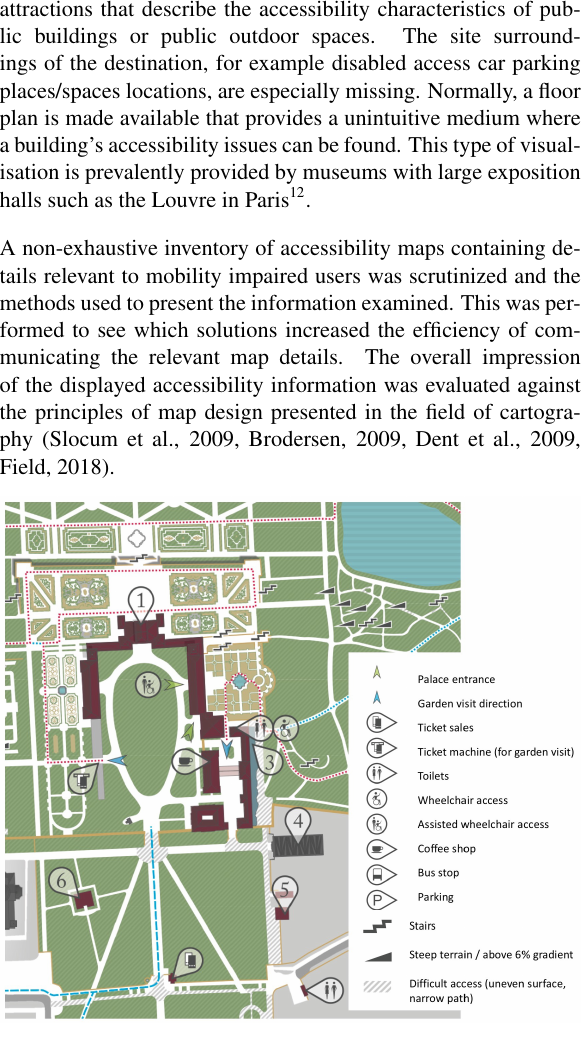
Figure 1. The Palace and Park in Wilan´ow map with legend,